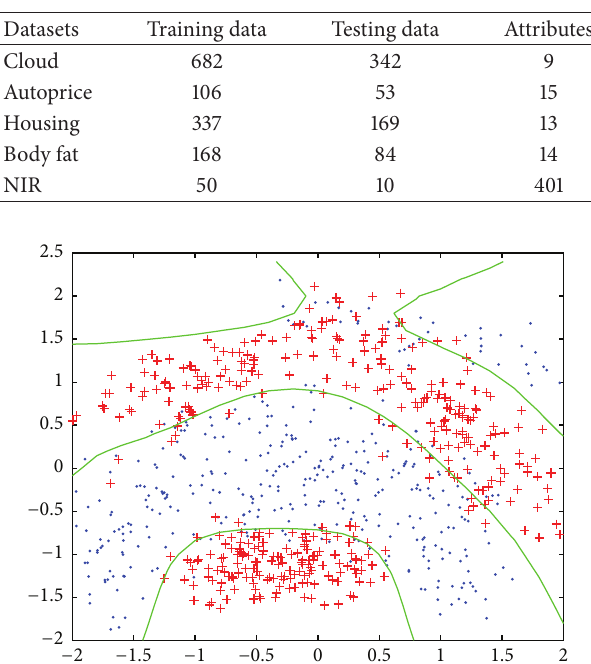
Figure 8: The boundaries of Gau-H KELM algorithms in Banana dataset.